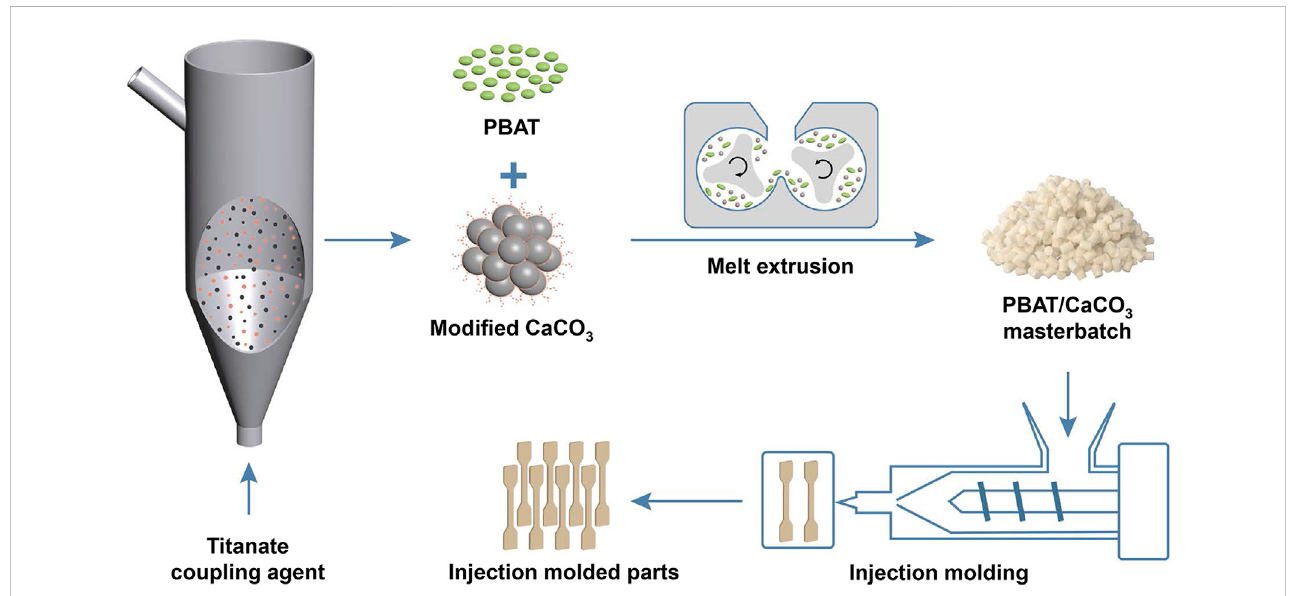
FIGURE 1 Schematic diagram for the preparation of gas — solid fl uidization modi fi ed CaCO 3 and the corresponding PBAT/CaCO 3 composite.